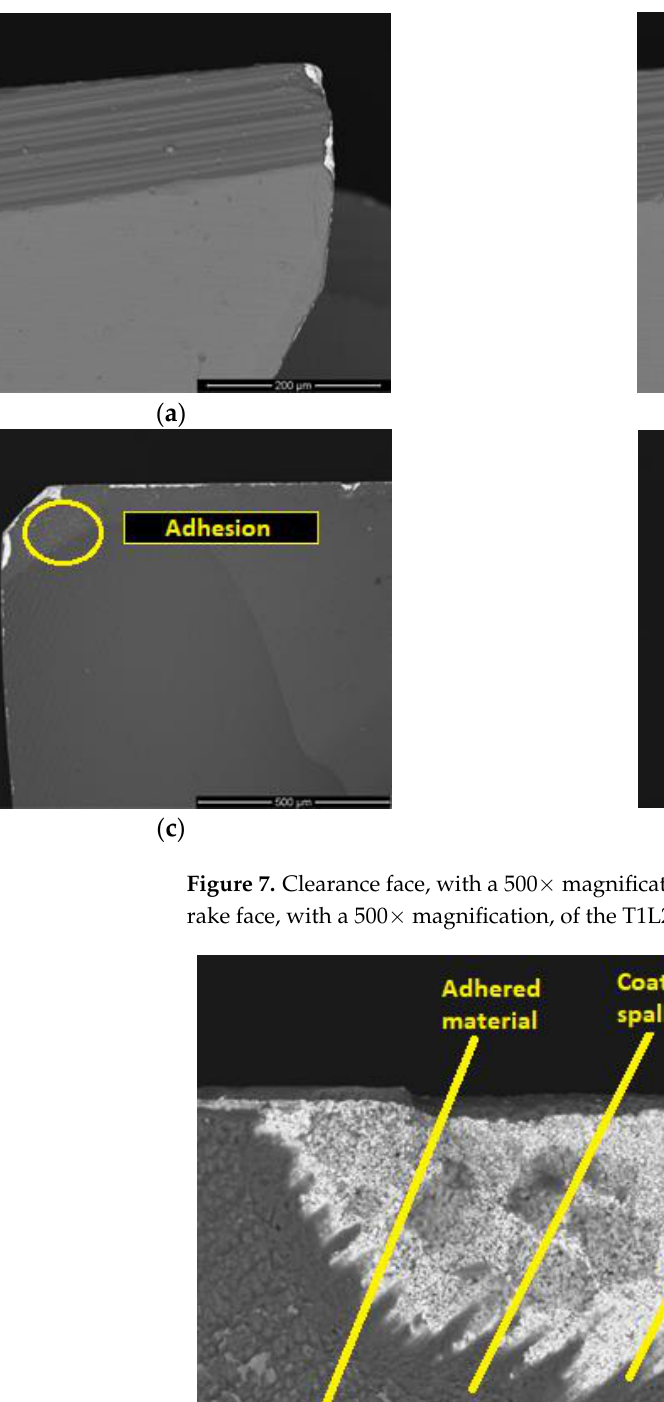
Figure 8. Wear mechanism analysis of the T1L2F125 rake face.